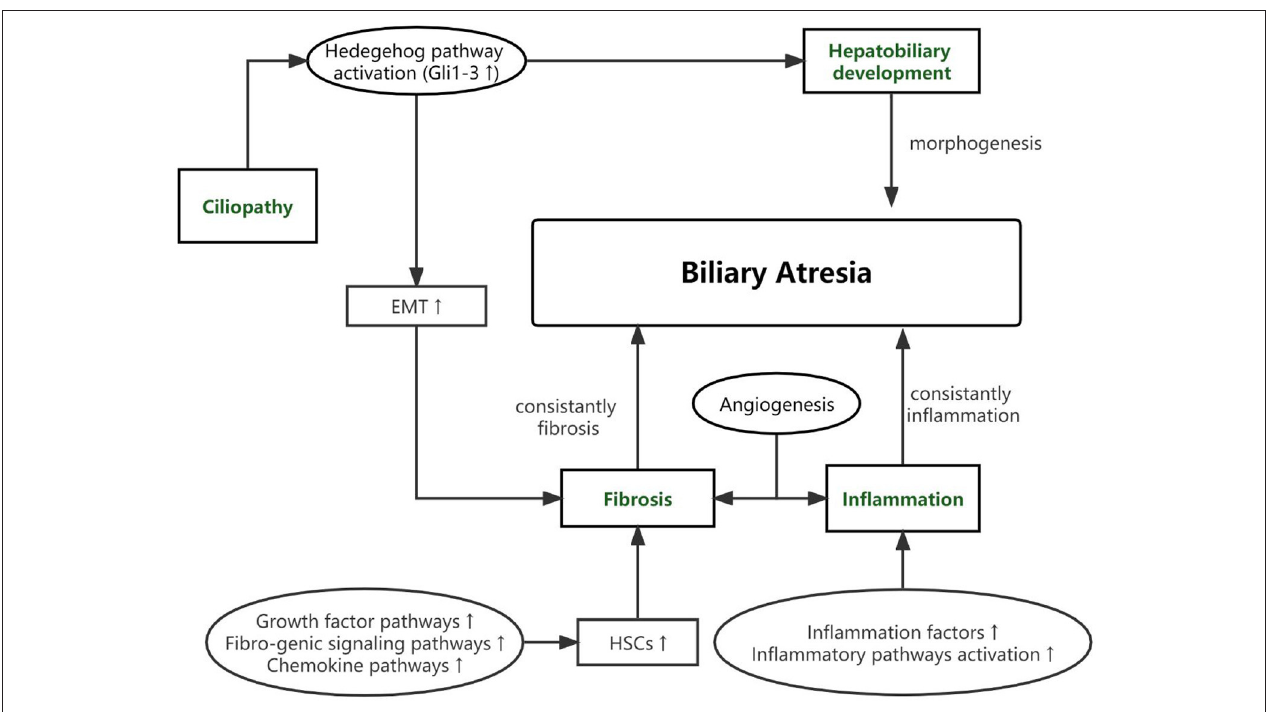
FIGURE 1 | The connection among four pathways and between the pathogenic pathways of